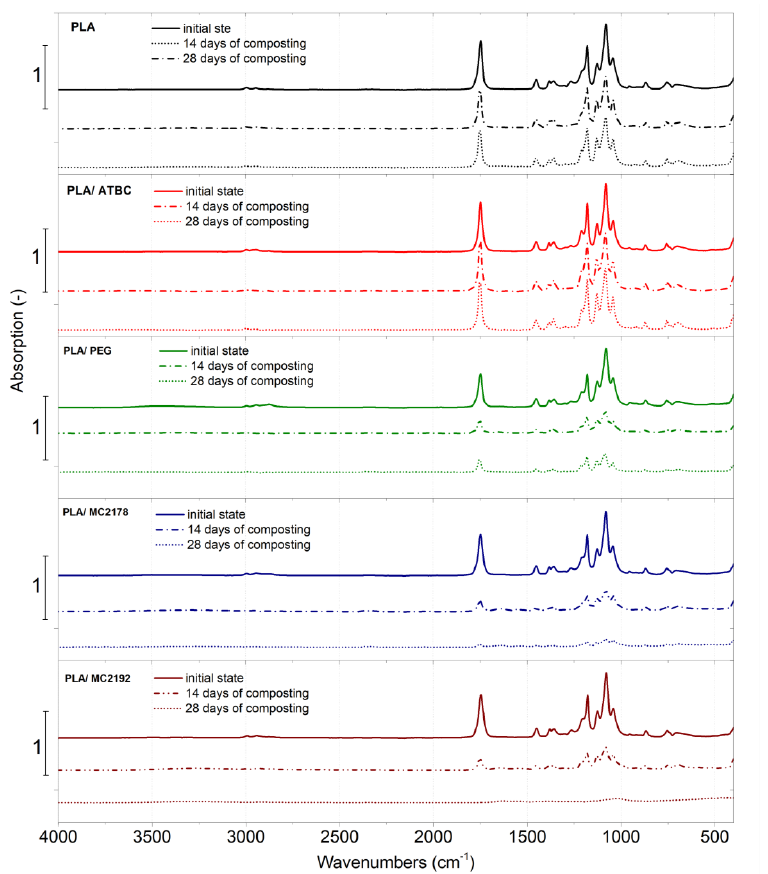
Figure 16. FTIR spectra of as-produced PLA films at initial state and after 14 days and 28 days of thermophilic composting.